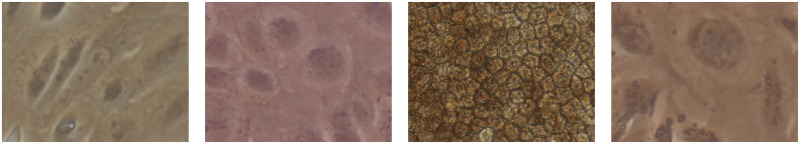
Illustrative images of the RPE maturation stages (classes).From left to right: fusiform, epithelioid, cobblestone and mixed (Fusiform and Epithelioid).